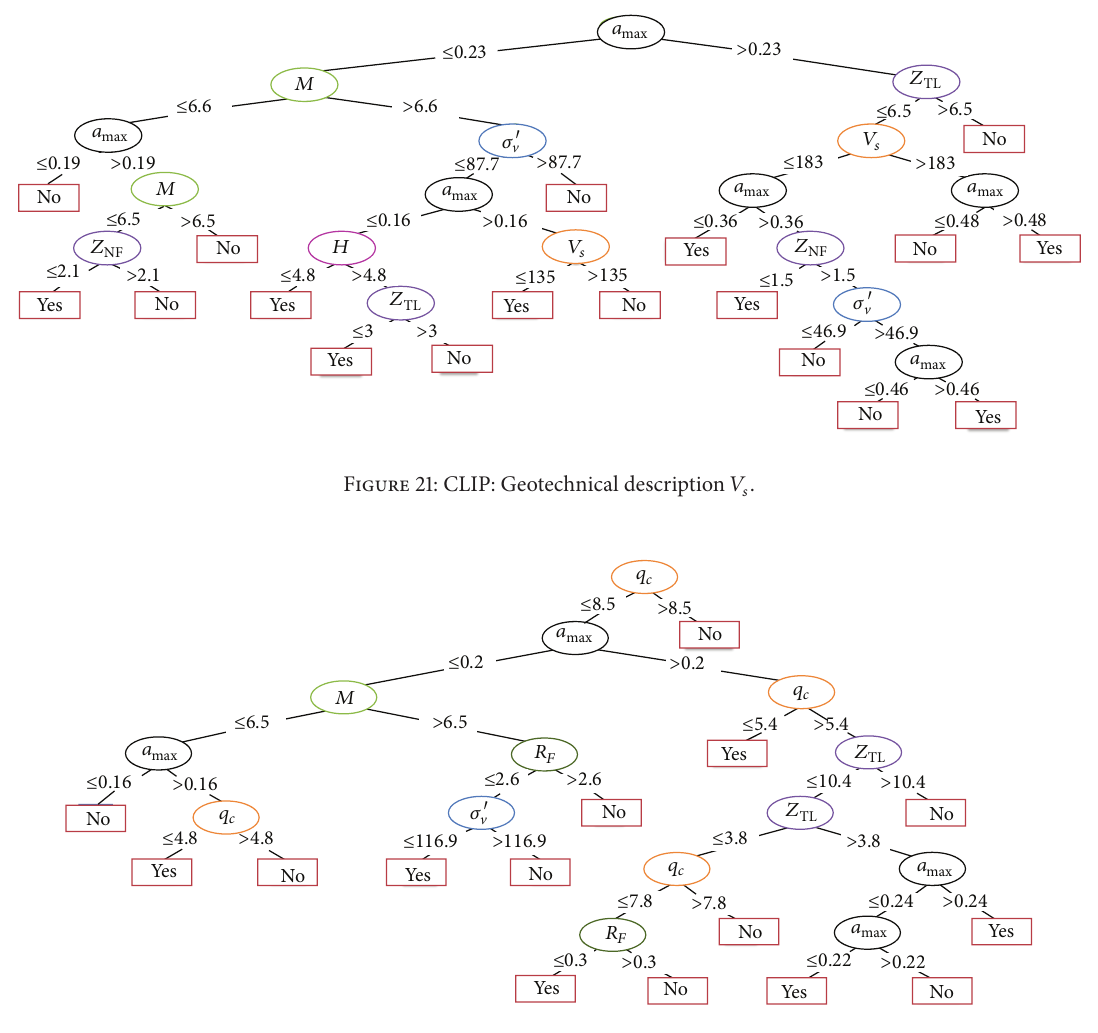
Figure 22: CLIP: Geotechnical description 𝑞 𝑐